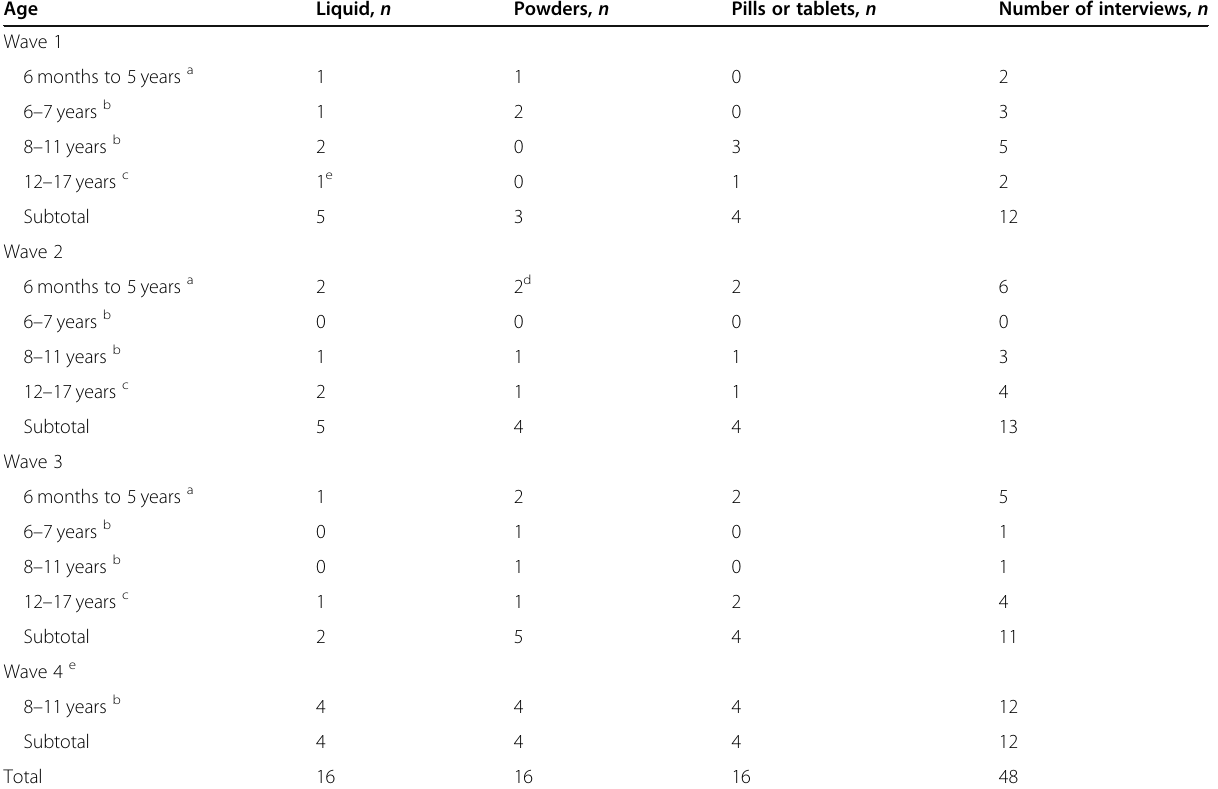
Table 3 Distribution of participants by wave, age, and formulation Age Liquid, n Powders,